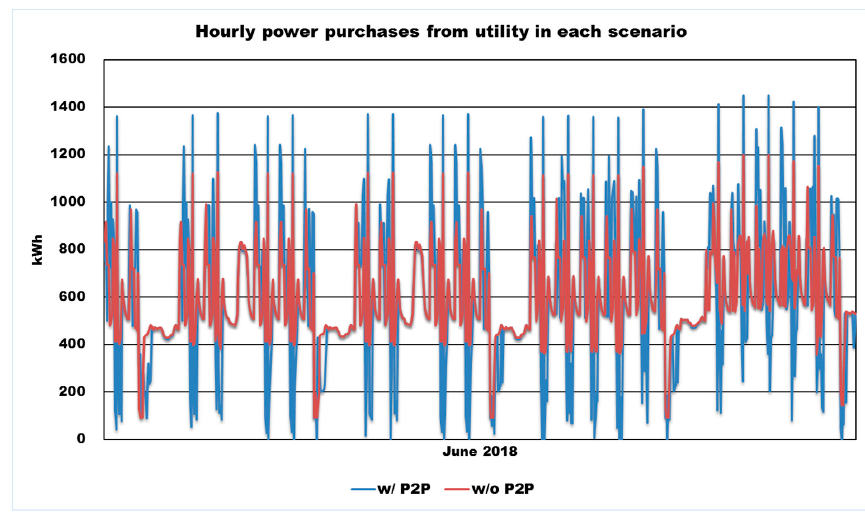
Figure 9. Comparison of hourly power purchases from utility in each scenario.